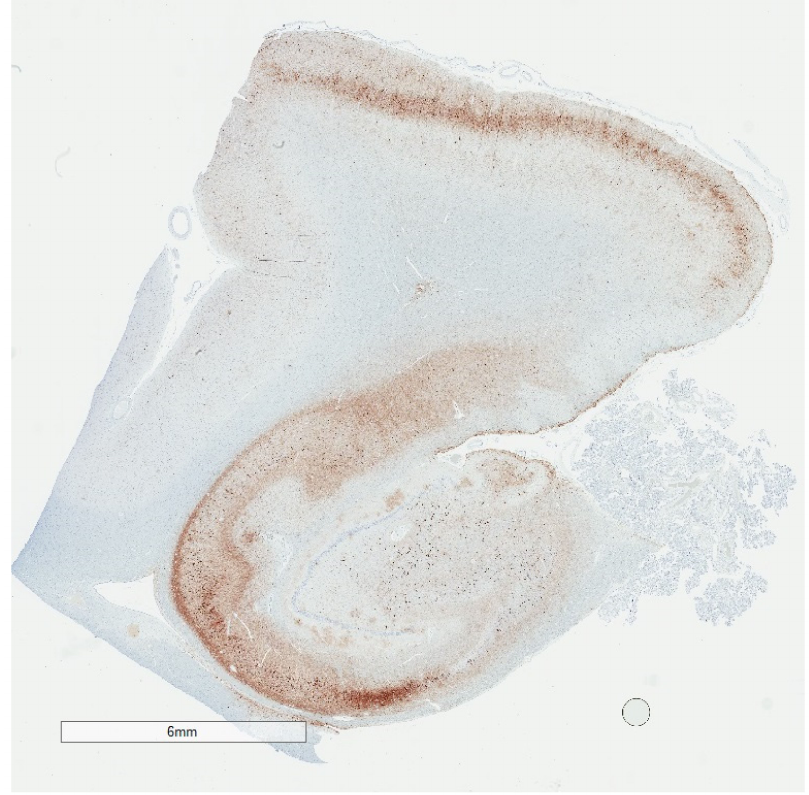
Figure 4. Low magnification p-tau (AT8) immunohistochemistry of the hippocampus showing changes consistent with Braak stage IV. Despite the extensive p-tau labeling, individuals with Braak stage IV may have been cognitively normal during